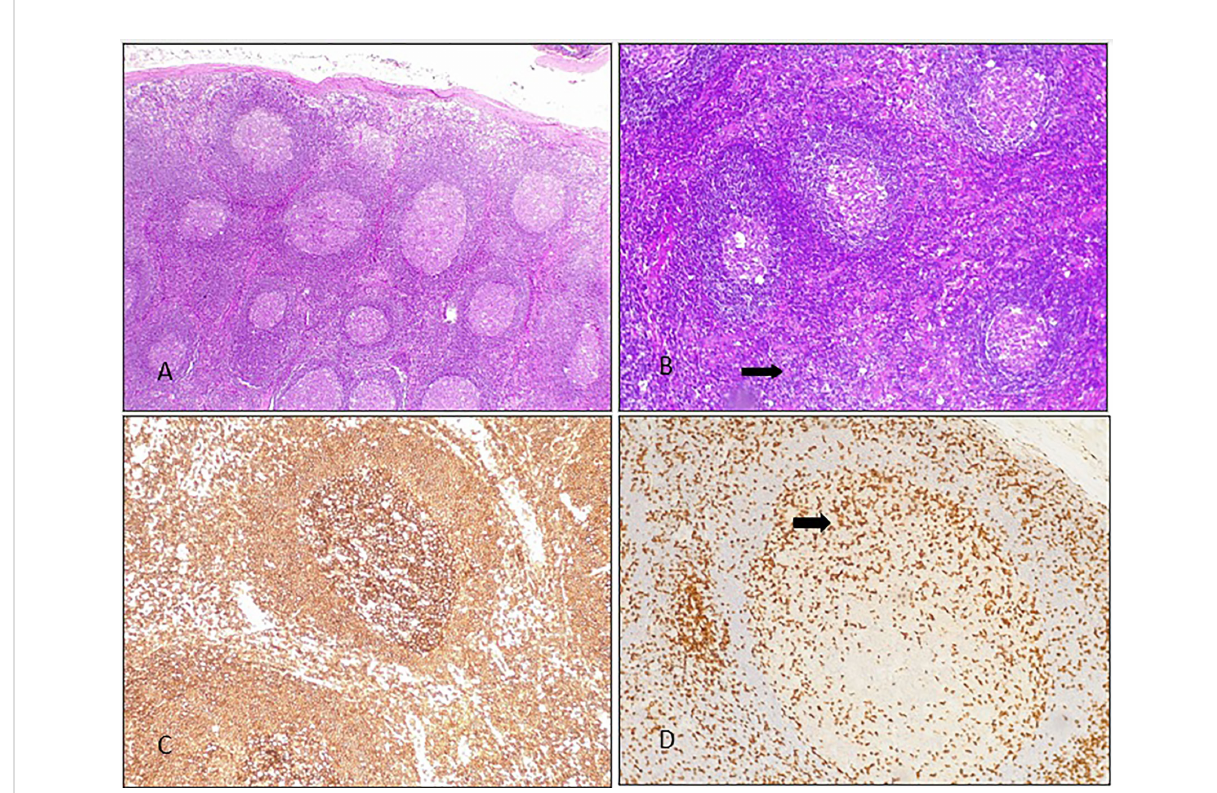
FIGURE 3 Lymph node histology from BENTA patient 2B: (A) several secondary follicles with scant interfollicular tissue. HE 10X. (B) Secondary follicles with expanded interfollicular areas were seen (there is some starry sky, arrow). 20X HE. (C) CD20: positive lymphocytes in most of the components of the follicle (germinal center and mantle). (D) CD3: occasional positive lymphocytes in the germinal center of a large secondary follicle